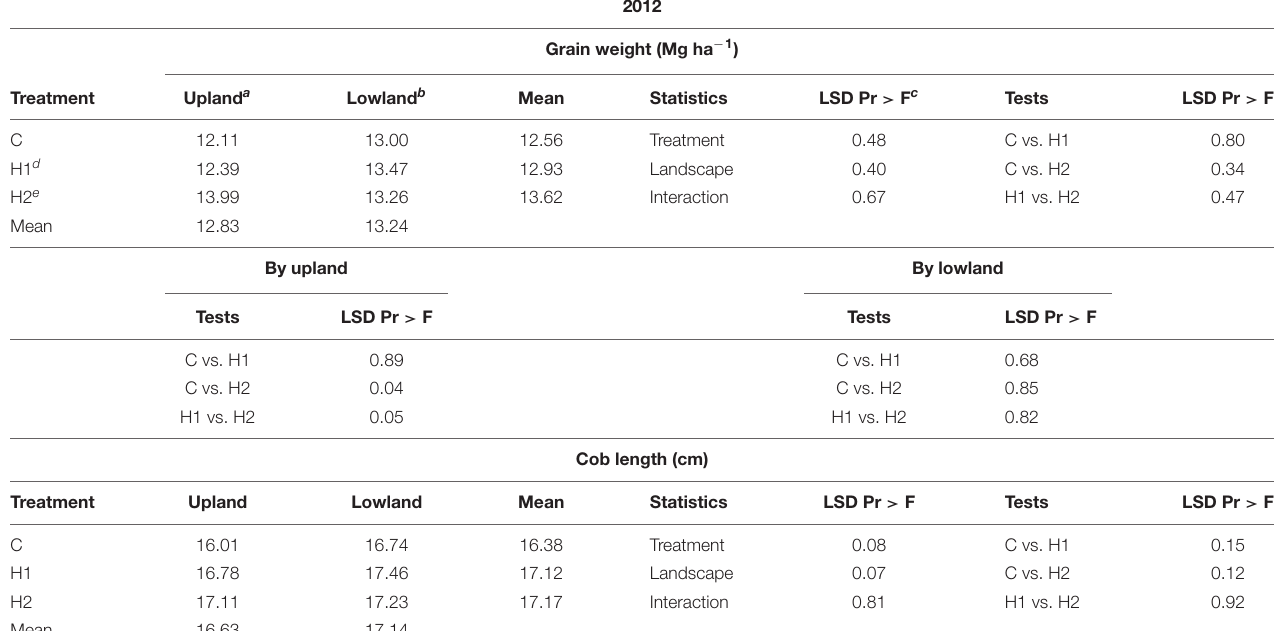
TABLE 4 | Maize yield component responses to humic product application for the Ames on-farm field trial (2012, 2014, and 2016).